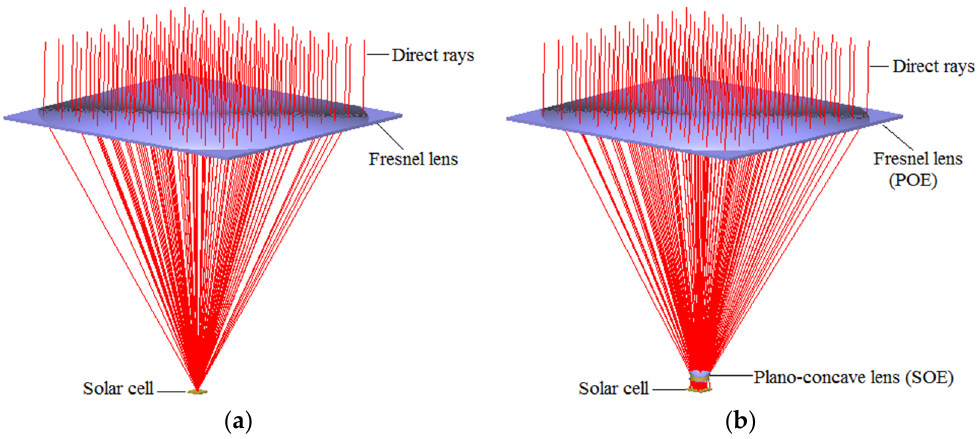
Figure 6. Layout of CPV units under ray ‐ tracing simulation: ( a ) a conventional CPV unit; and ( b ) the proposed CPV unit.